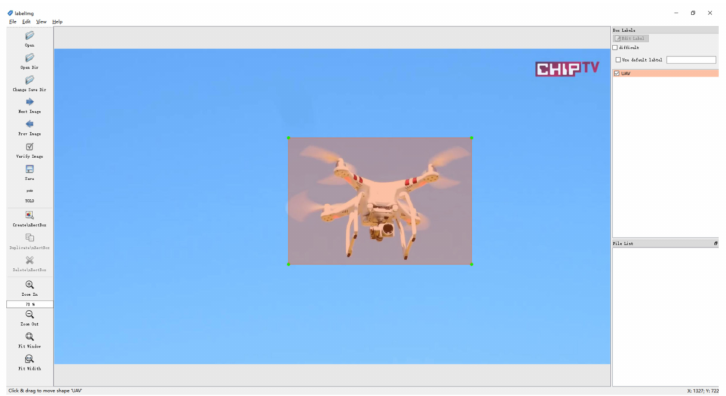
Figure 10. Image labeling of the dataset.